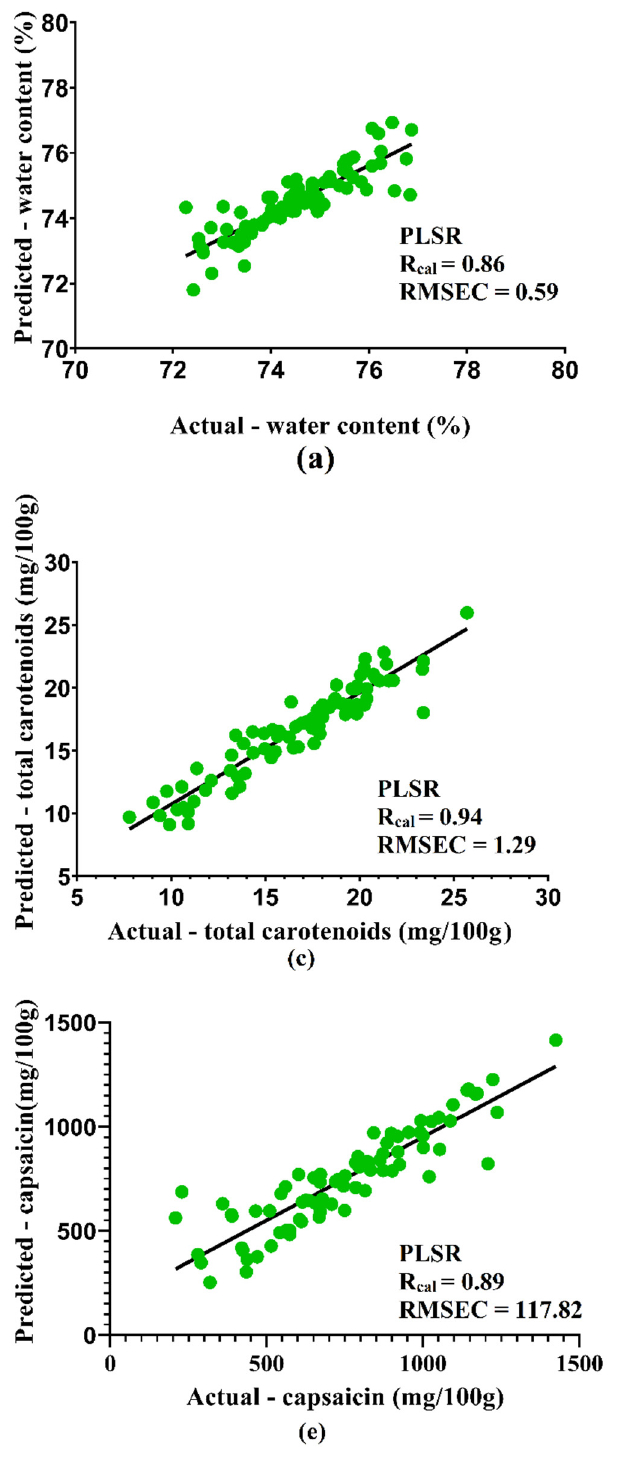
Figure 2. Scatter plots and regression line of calibration set (green) and prediction set (orange) of water content ( a , b ), total carotenoids ( c , d ), and capsaicin ( e , f ) in green ‘Ratuni UNPAD’ cayenne pepper.